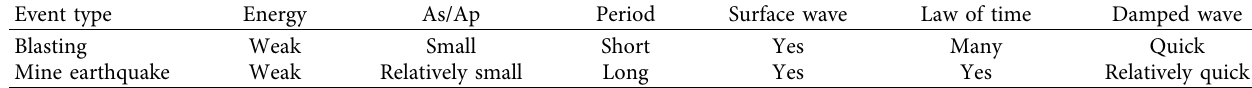
Table 1: Basic characteristics of mine earthquake and blasting